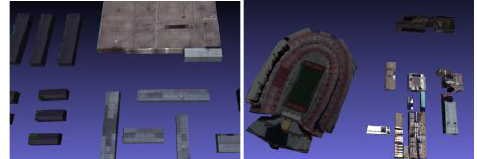
Fig. 3. Left: example of the regular (rectangular) building model, right: example of the irregular (non-rectangular) building